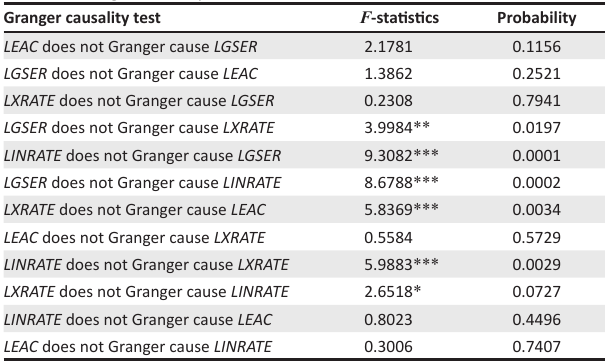
TABLE 6: Granger causality test results.